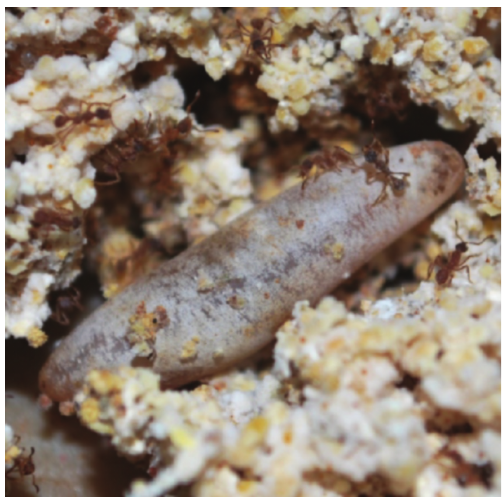
Figure 1: L. albirostris egg on a colony of A . cf. goniodes . Note that the workers have planted pieces of fungal garden on the egg’s shell.